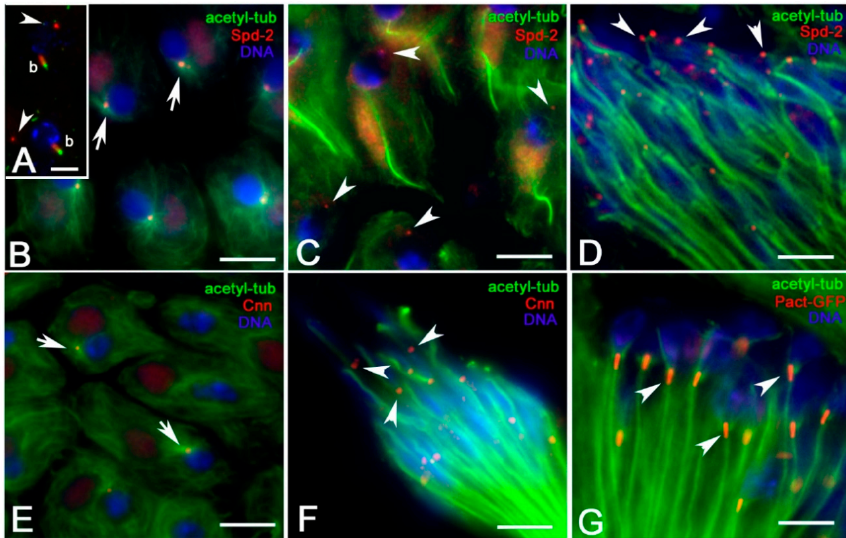
Figure 6. ( A ) Nocodazole-treated Drosophila spermatids: γ -tubulin is found as a small spot at one side of the nucleus (arrowheads) and around the basal body (b). Localization of centrosomal proteins involved in γ -tubulin recruitment during early spermiogenesis. Spd-2 is localized to the basal bodies in onion stage spermatids (arrows, ( B )) and to the apical regions of young elongating (arrowheads, ( C )) and leaf stage (arrowheads, ( D )) spermatids. Cnn localizes to the basal bodies in onion stage spermatids (arrows, ( E )) and centriole adjuncts in leaf stage spermatids (arrowheads, ( F )). Pact-GFP colocalizes with the centrioles (arrowheads, ( G ). Scale bars: ( A ), 5 µ m; ( B – G ), 10 µ